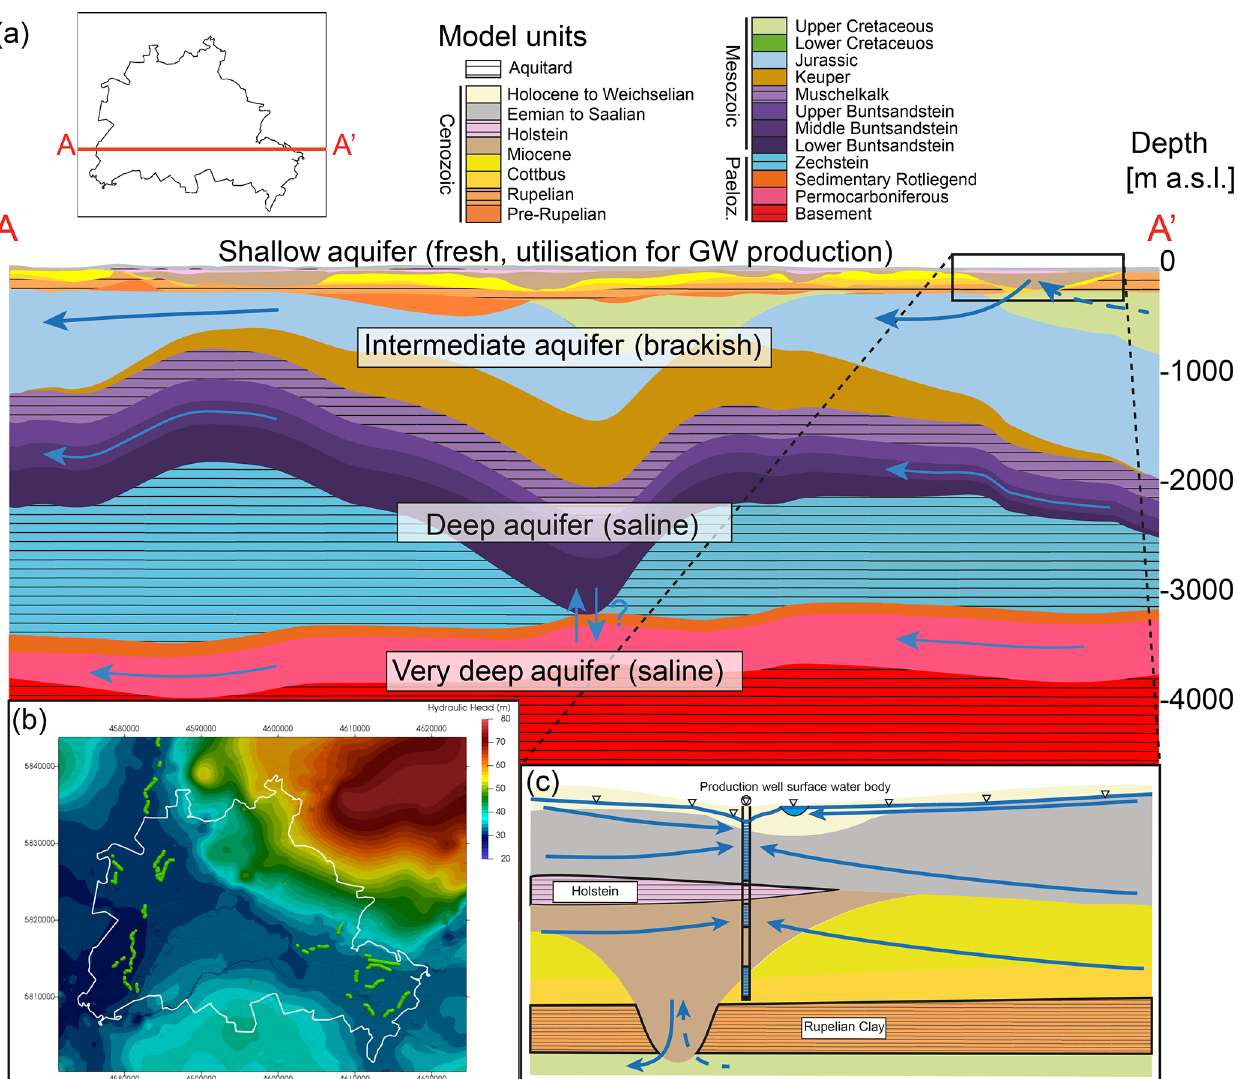
Figure 1. Hydrogeological setup of model area. (a) Geological cross section and hydrogeological compartmentalisation of the model area (location in upper left corner). Hatched units represent aquitards. Blue arrows represent conceptual flow paths. Vertical exaggeration = 5 × . (b) Natural hydraulic head distribution: green dots = well locations. Coordinates [m] in Gauß-Krüger DHDN Zone 4. (c) schematic zoom of shallow-intermediate domain, modified from Limberg and Thierbach (1997). Upper blue line indicates groundwater head distribution modified by pumping well activity. Blue arrows represent conceptual flow paths. Vertical exaggeration = 15 ×